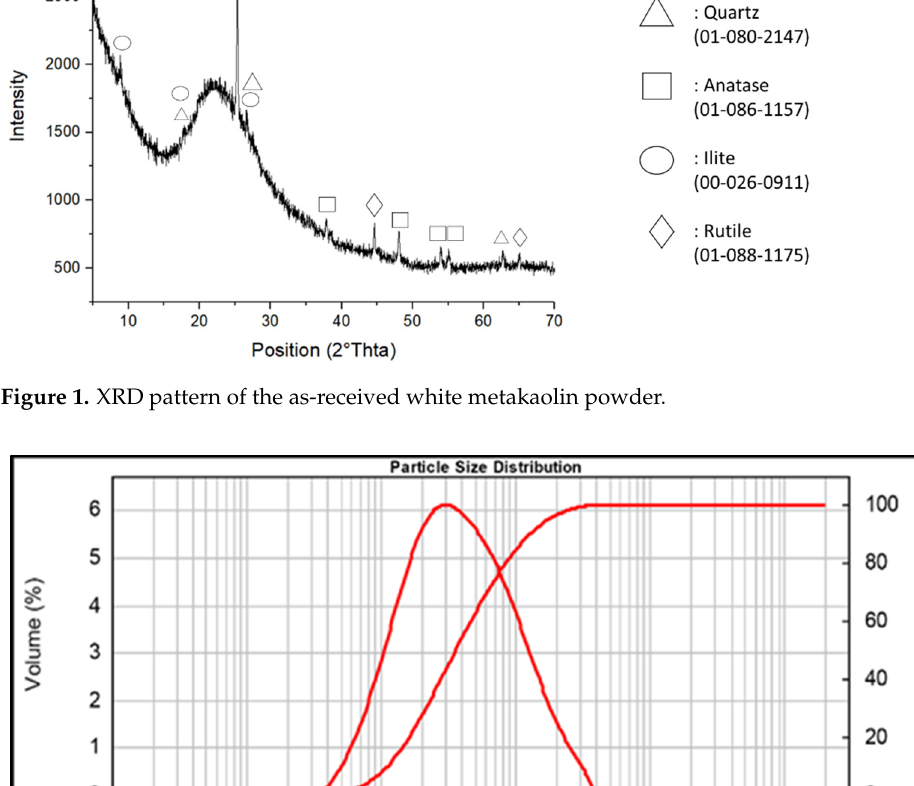
Figure 2. Particle size distribution of the as-received white metakaolin